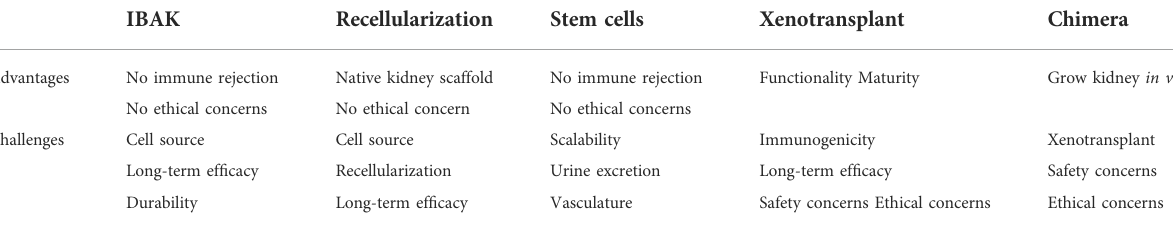
TABLE 1 Advantages and challenges of different kidney replacement